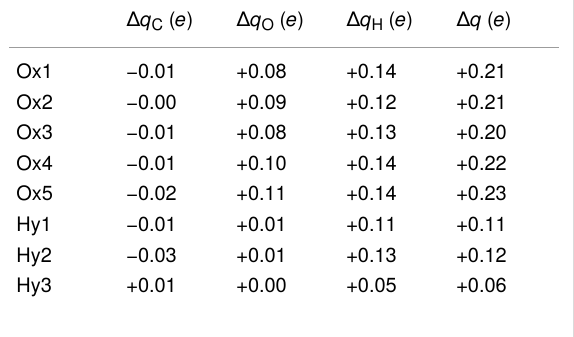
Table 2: The sum of partial charges of C, O, and H in an adsorbed camphor molecule ( Δ q C , Δ q O , and Δ q H , respectively) and the total partial charge of the camphor molecule ( Δ q